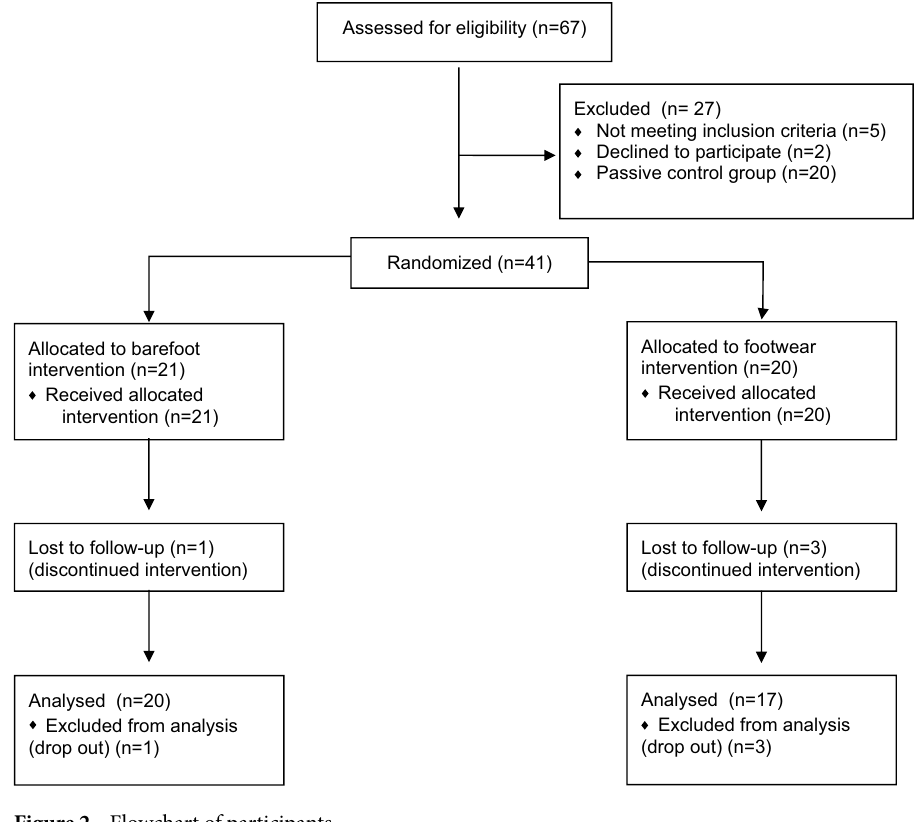
Figure 2. Flowchart of